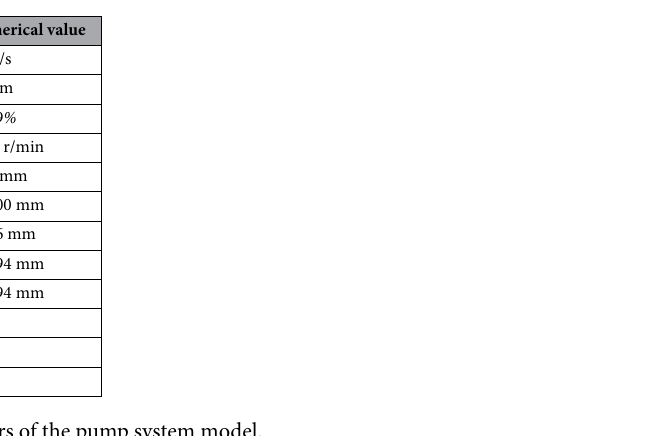
Table 1. Main geometric parameters of the pump system